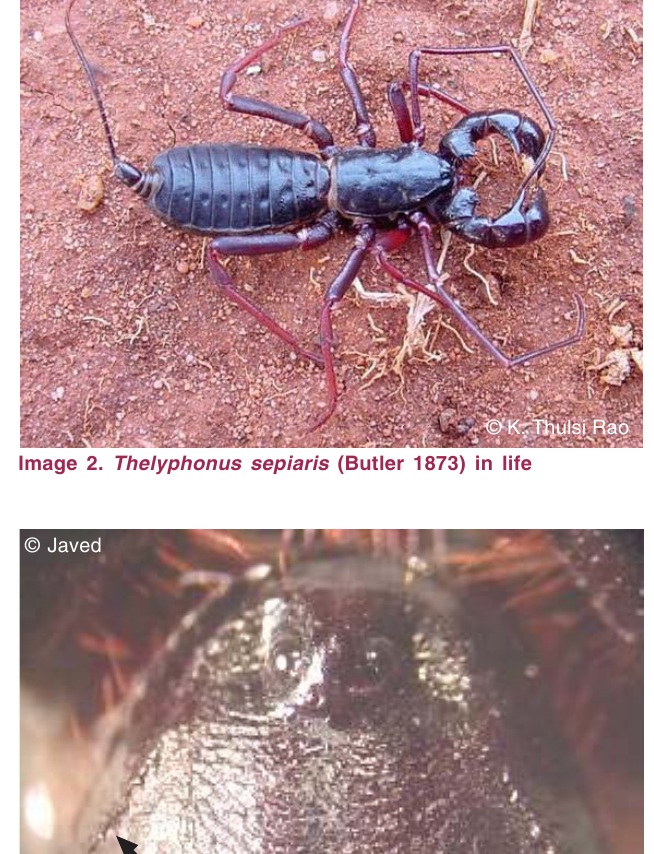
Image 3. Dorsal view of thorax-anterior region (arrow pointing towards a ocular keel)